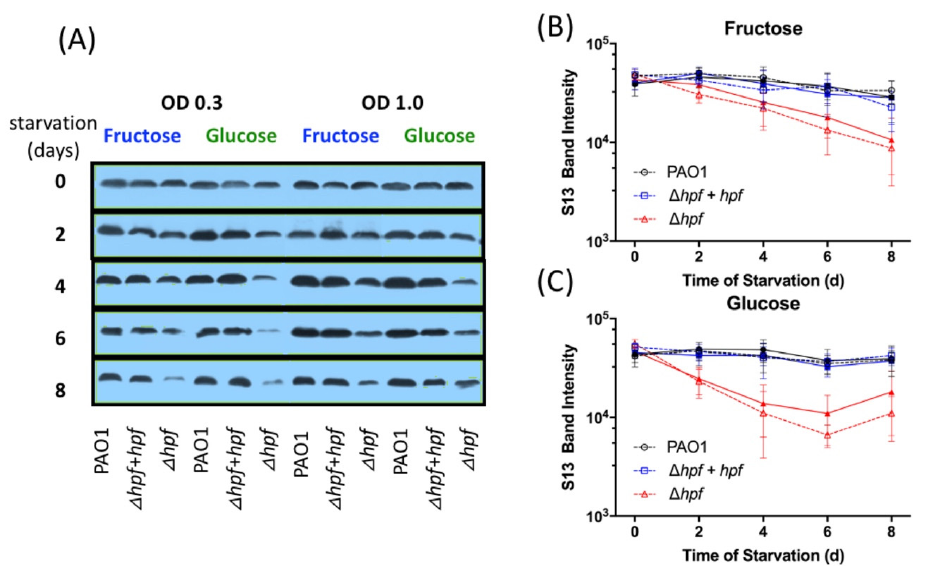
Figure 9. Quantification of P. aeruginosa S13 band intensity over the course of 8 d of starvation, from whole cell extracts. Strains were pre-cultured in MOPS minimal media with either fructose or glucose as the sole carbon source. ( A ) Representative immunoblot of S13 from whole cell extracts. ( B ) Quantification of S13 signal intensity obtained by densitometry of three immunoblots, when strains were cultured in MOPS-fructose. Solid lines and symbols indicate cells were pre-cultured to O.D. 600 = 1.0 and dashed lines and open symbols indicate cells were pre-cultured to O.D. 600 = 0.3. ( C ) Quantification of S13 signal intensity when strains were cultured in MOPS- glucose.. Data show the mean and standard error of three independent biological replicates.